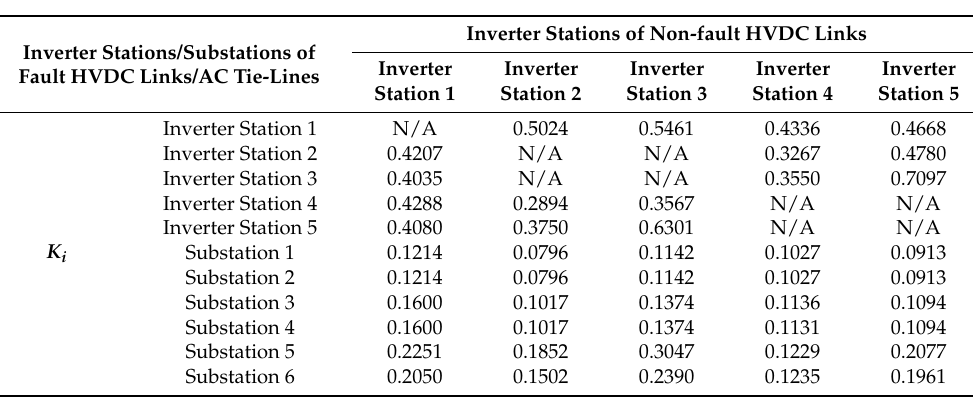
Table A2. K i for inverters stations of non-fault HVDC links in receiving-end systems.